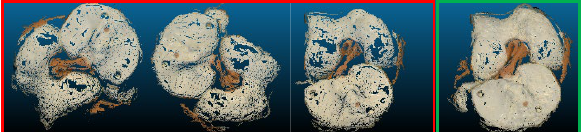
Figure 9. Single point clouds from individual image triplets at positions 120°, 240°, 360° of the circular image sequence (framed red). Oriented point clouds, transformed into first camera according to VO/ SLAM transformation matrix for individual 6DOF of the image triples (framed green).